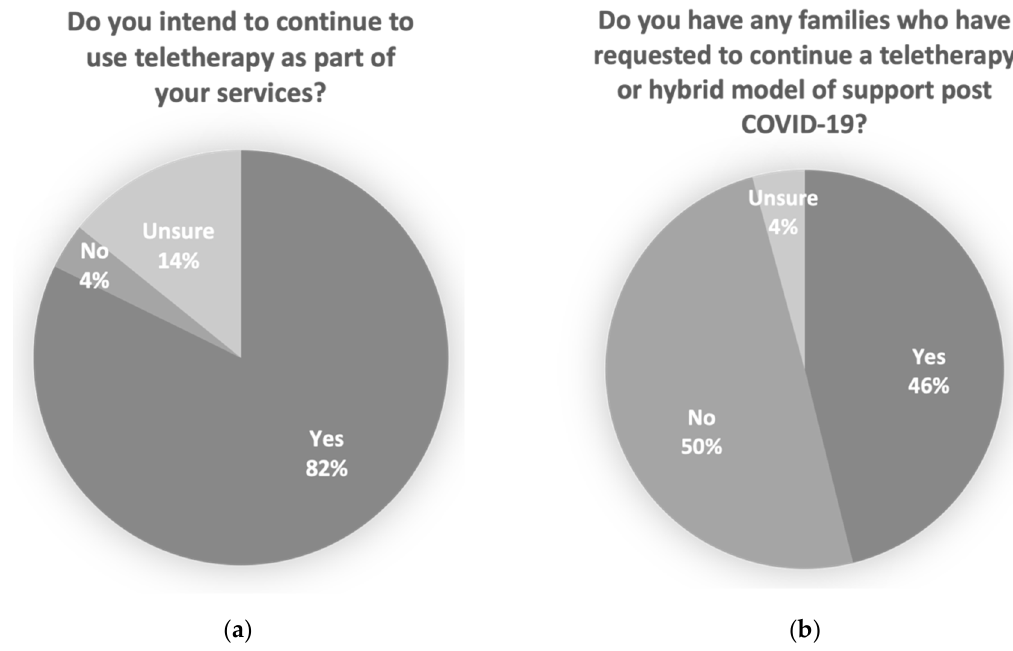
Figure 1. Practitioner reported intention to continue a teletherapy model of service including ( a ) percentage of practitioners who reported that they intend to continue to use teletherapy as part of their service and ( b ) percentage of therapists who have had families request to have teletherapy or a hybrid model of support continue post COVID-19.